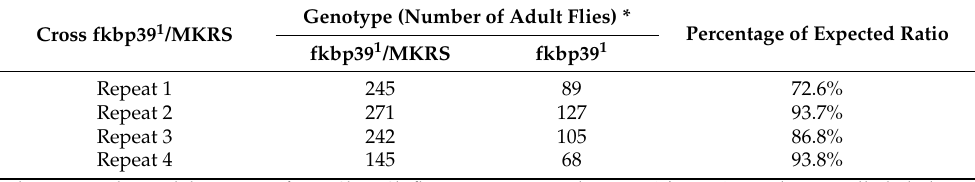
Table 1. The fkbp39 1 is viable.